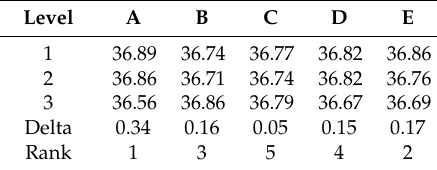
Table 7. Response table for the S/N ratios